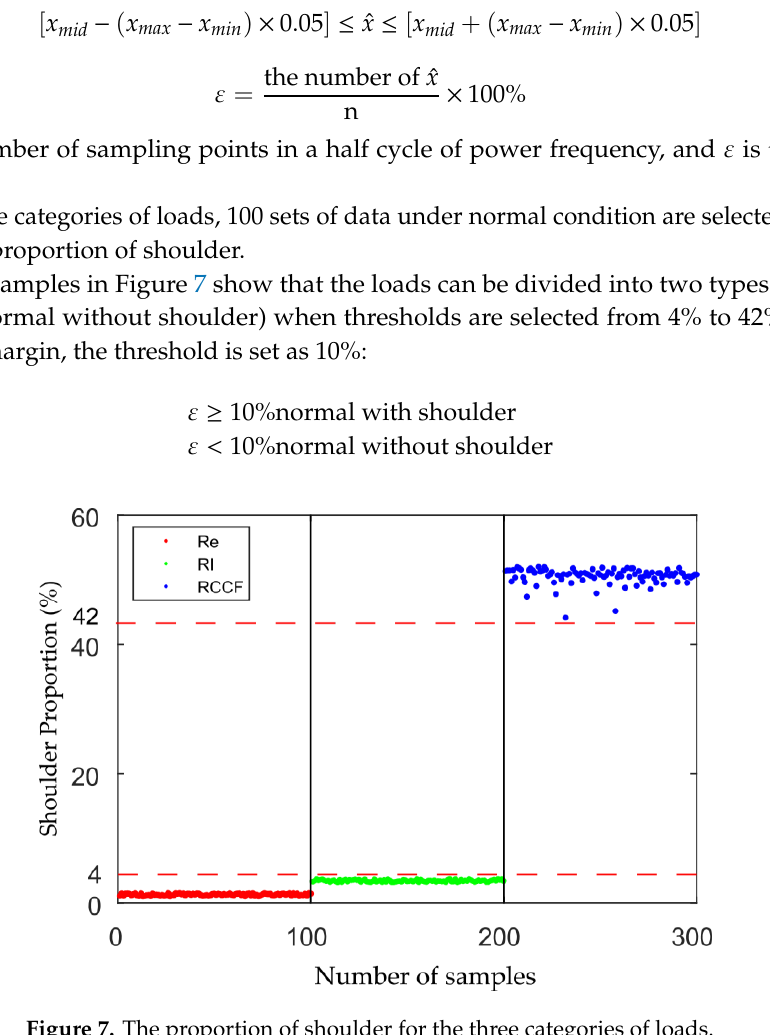
Figure 7. The proportion of shoulder for the three categories of loads.